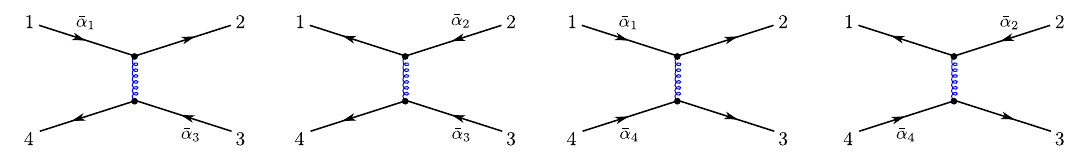
Figure 8 . We depict the four N = 2 YM exchanges which add up to the full one-loop exchange in N = 4